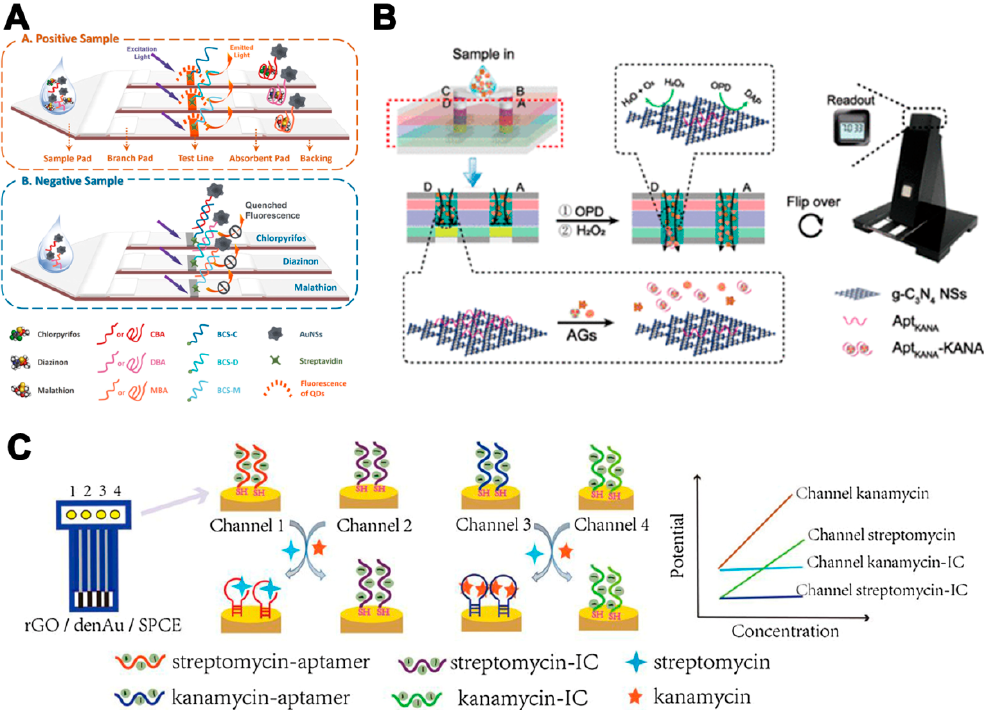
Figure 5. The assays based on multi-aptamers in multiple-channel strategies. ( A ) Illustration of a fluorescent aptamer-based lateral flow biosensor consisting of three specific test lines for the detection of three pesticide residues [82]. ( B ) Illustration of a work mode for the paper-based device digital fluorescence detector platform. The red dotted line shows the location of the cross-section. The left channel B–D is the assay region and the right channel A is the control region [83]. ( C ) Illustration of a novel potentiometric aptasensor array for the simultaneous detection of streptomycin and kanamycin with dual-channel internal calibration [84]. Reproduced with permission from [82]. Copyright Elsevier, 2018. Reproduced with permission from [83]. Copyright American Chemical Society, 2019. Reproduced with permission from [84]. Copyright Elsevier, 2020.